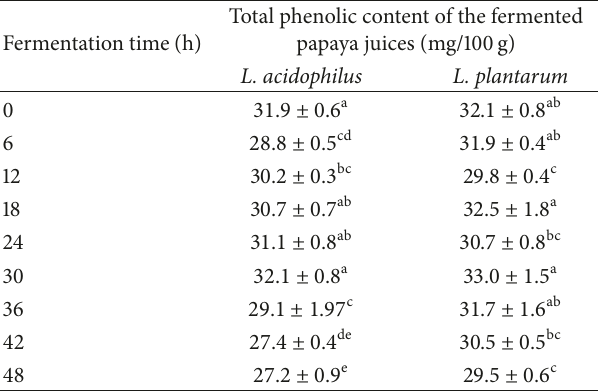
Table 1: Changes in total phenolic content of the fermented papaya